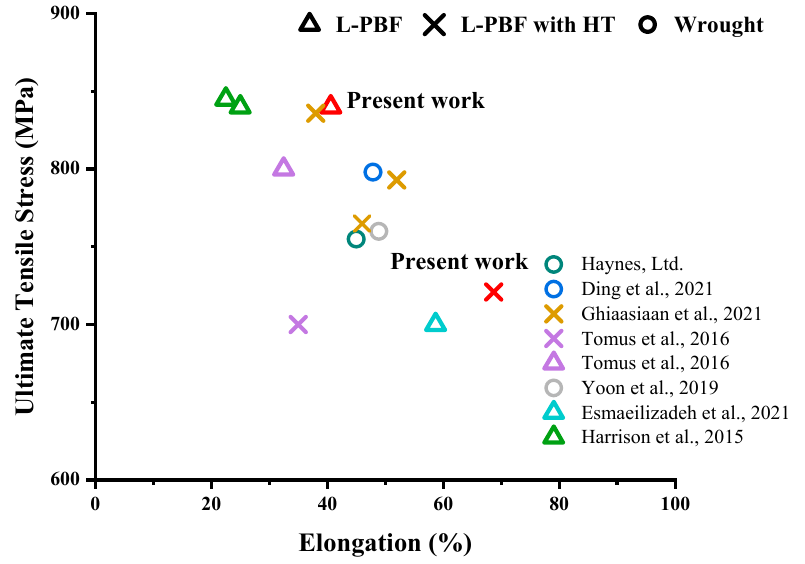
Figure 8. The comparison of ultimate tensile strength and ductility of GH3536 superalloy from our work and literatures [18,24,30,34,41,47,48].